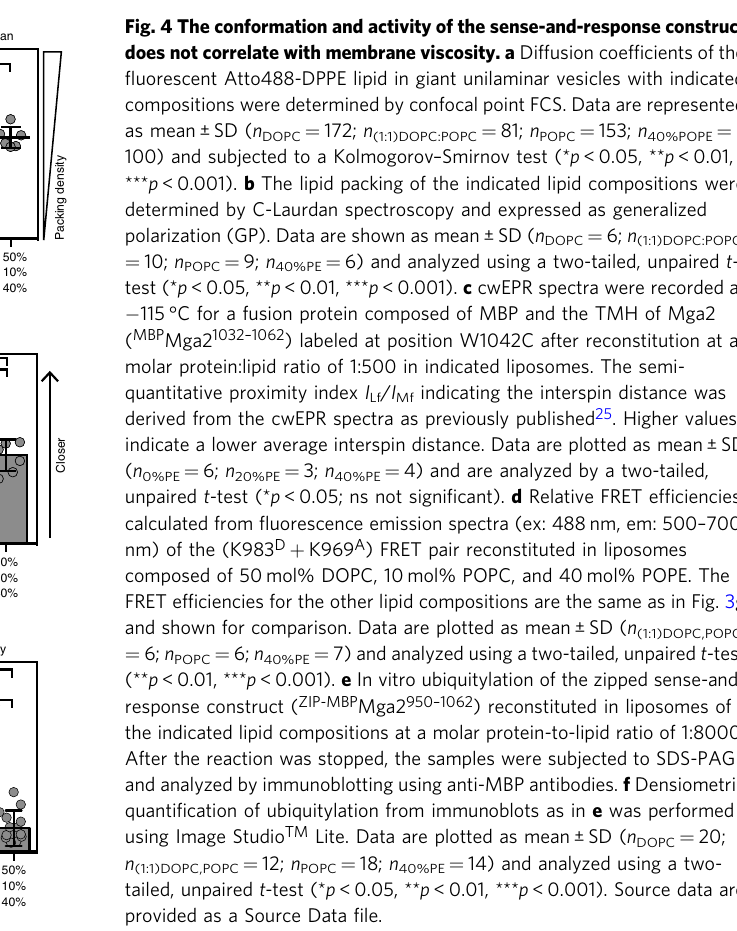
Fig. 4 The conformation and activity of the sense-and-response construct does not correlate with membrane viscosity. a Diffusion coef fi cients of the fl uorescent Atto488-DPPE lipid in giant unilaminar vesicles with indicated compositions were determined by confocal point FCS. Data are represented as mean ± SD ( n DOPC = 172; n (1:1)DOPC:POPC = 81; n POPC = 153; n 40%POPE = 100) and subjected to a Kolmogorov – Smirnov test (* p < 0.05, ** p < 0.01, *** p < 0.001). b The lipid packing of the indicated lipid compositions were determined by C-Laurdan spectroscopy and expressed as generalized polarization (GP). Data are shown as mean ± SD ( n DOPC = 6; n (1:1)DOPC:POPC = 10; n = 9; n = 6) and analyzed using a two-tailed, unpaired t - POPC 40%PE 115 °C for a fusion protein composed of MBP and the TMH of Mga2 ( MBP Mga2 1032 – 1062 ) labeled at position W1042C after reconstitution at a molar protein:lipid ratio of 1:500 in indicated liposomes. The semi- quantitative proximity index I Lf / I Mf indicating the interspin distance was derived from the cwEPR spectra as previously published 25 . Higher values indicate a lower average interspin distance. Data are plotted as mean ± SD ( n 0%PE = 6; n 20%PE = 3; n 40%PE = 4) and are analyzed by a two-tailed, unpaired t -test (* p < 0.05; ns not signi fi cant). d Relative FRET ef fi ciencies calculated from fl uorescence emission spectra (ex: 488 nm, em: 500 – 700 nm) of the (K983 D + K969 A ) FRET pair reconstituted in liposomes composed of 50 mol% DOPC, 10 mol% POPC, and 40 mol% POPE. The FRET ef fi ciencies for the other lipid compositions are the same as in Fig. 3g and shown for comparison. Data are plotted as mean ± SD ( n (1:1)DOPC,POPC = 6; n = 6; n = 7) and analyzed using a two-tailed, unpaired t -test POPC 40%PE (** p < 0.01, *** p < 0.001). e In vitro ubiquitylation of the zipped sense-and- response construct ( ZIP-MBP Mga2 950 – 1062 ) reconstituted in liposomes of the indicated lipid compositions at a molar protein-to-lipid ratio of 1:8000. After the reaction was stopped, the samples were subjected to SDS-PAGE and analyzed by immunoblotting using anti-MBP antibodies. f Densiometric quanti fi cation of ubiquitylation from immunoblots as in e was performed using Image Studio TM Lite. Data are plotted as mean ± SD ( n DOPC = 20; n = 12; n = 18; n = 14) and analyzed using a two- (1:1)DOPC,POPC POPC 40%PE tailed, unpaired t -test (* p < 0.05, ** p < 0.01, *** p < 0.001). Source data are provided as a Source Data fi